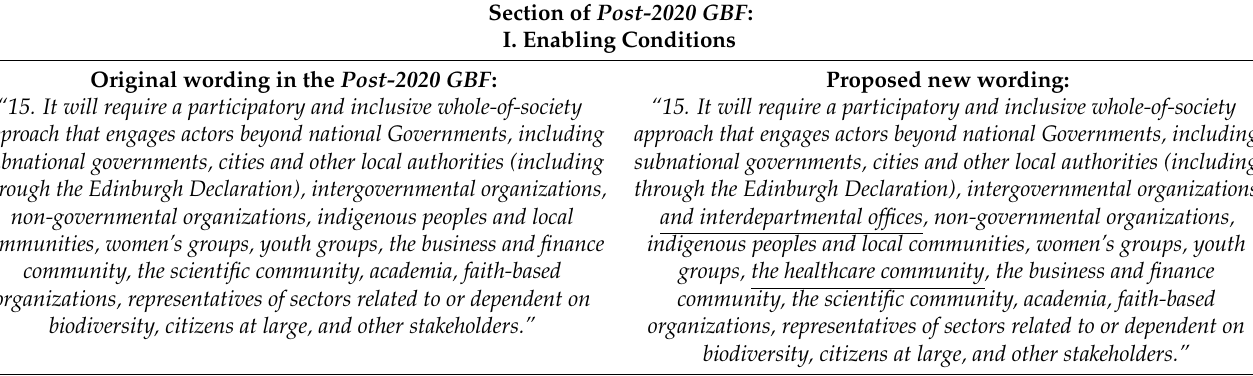
Table 3. Suggested revised health-inclusion statement and rationale for “Section I. Enabling Condi- tions” within the Post-2020 GBF .